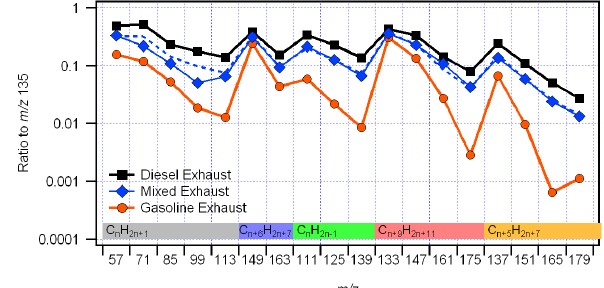
Fig. 10. Molar mixing ratio abundance of compounds measured in diluted diesel exhaust by VOC (solid bars) and IVOC (striped bars) sampling modes at 80Td arranged by compound class: oxygenated compounds (gold bars), cycloalkanes (green), bicy- loalkanes (orange), alkylbenzenes (blue), naphthenic monoaromat- ics (red), naphthalenes (teal). Total IVOC alkane abundance is shown as separate bar labeled alk.